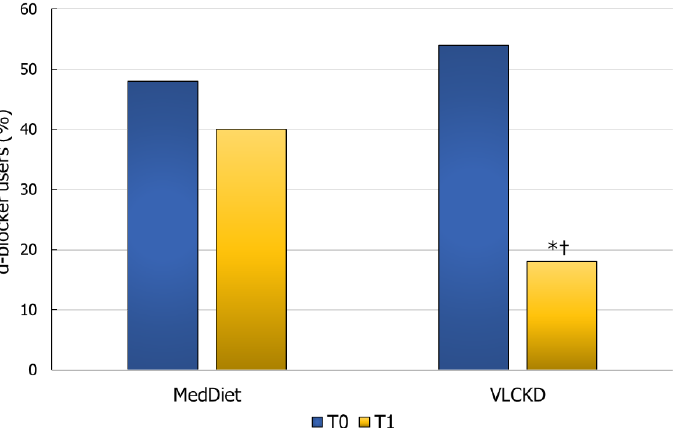
Figure 3. Percentage of α-blocker users for the treatment of urinary symptoms in patients with male accessory gland inflammation before (T0) and after three months (T1) on a Mediterranean diet (MedDiet) or very-low-calorie ketogenic diet (VLCKD). * p < 0.05 vs. VLCKD T0; † p < 0.05 vs. Med-Diet T1 (Chi-squared test).